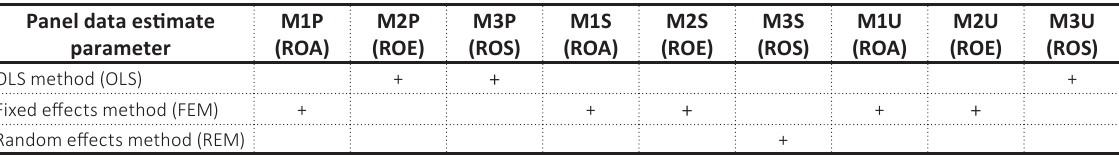
Table 3. Results of panel data estimate parameter selection for each of the models used Panel data estimate Fixed effects method (FEM) Random effects method